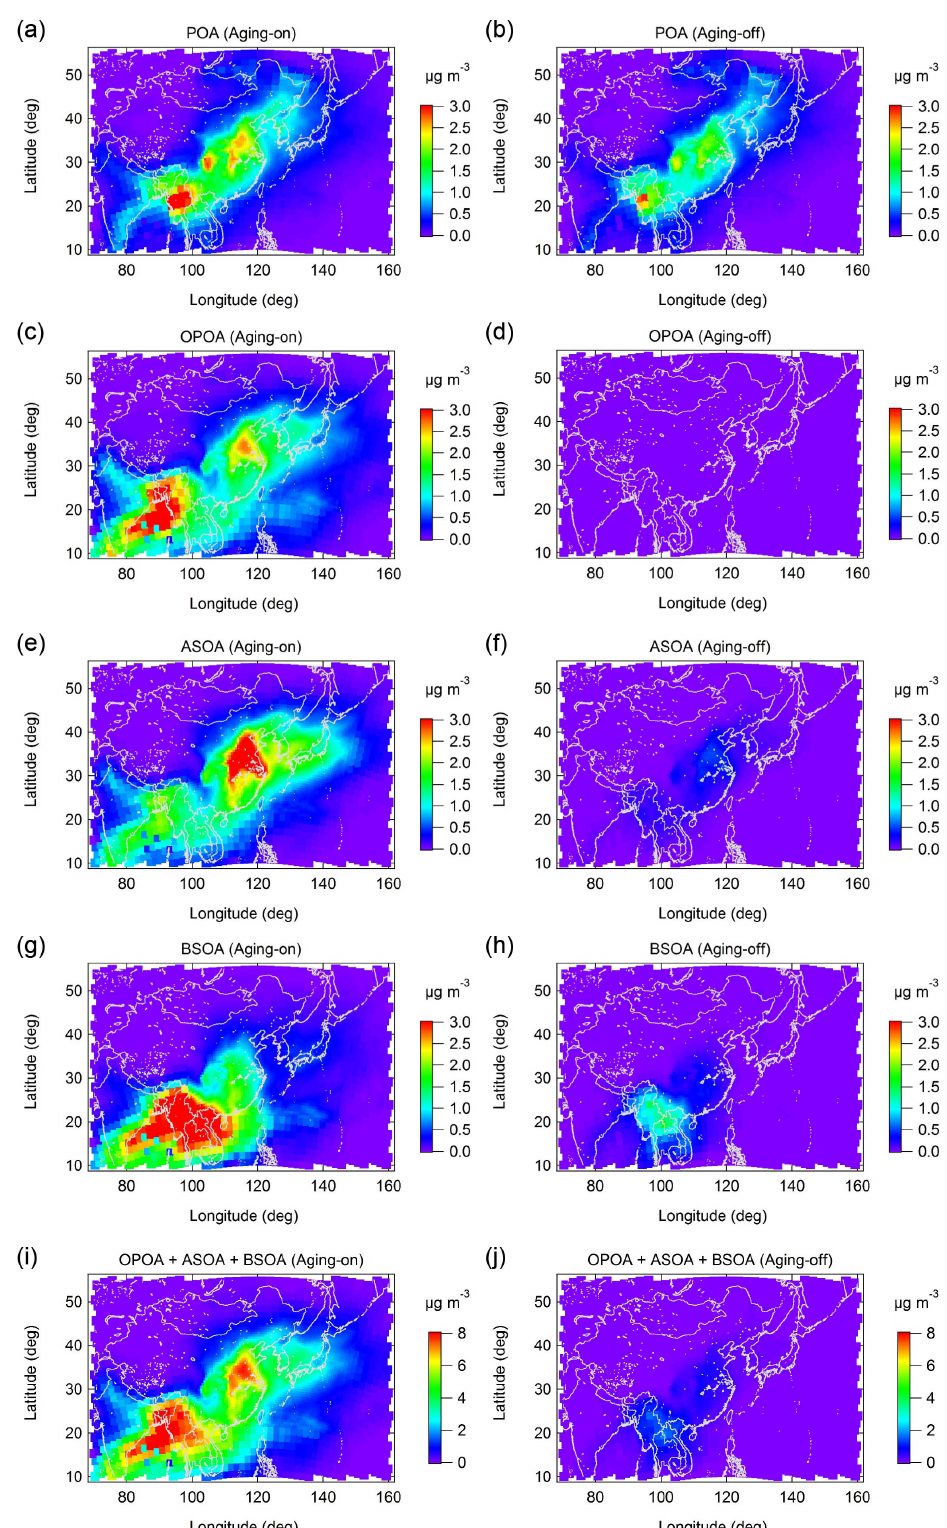
Figure 7. Period-averaged (24 March–26 April 2009) simulated mass concentrations of POA (a, b) , OPOA (c, d) , ASOA (e, f) , BSOA (g, h) , and total SOA (sum of OPOA, ASOA, and BSOA) (i, j) at an altitude of about 1km (layer number of 8, sigma level of 0.895). Left panels (a, c, e, g, i) are runs with aging, and right panels (b, d, f, h, j) are runs without